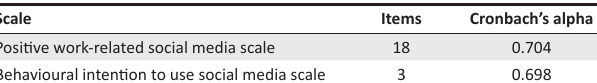
TABLE 3: Cronbach’s alpha coefficients for the scales comprising the measuring instrument.